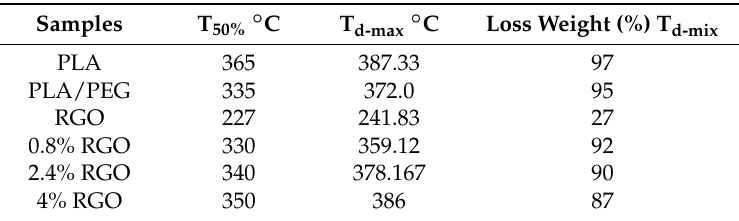
Table 2. Summary of the main results of the thermal degradation and the weight loss (%) of neat PLA, neat RGO powder, PLA/PBAT blend (90/10 wt/wt), and RGO/PLA/PEG